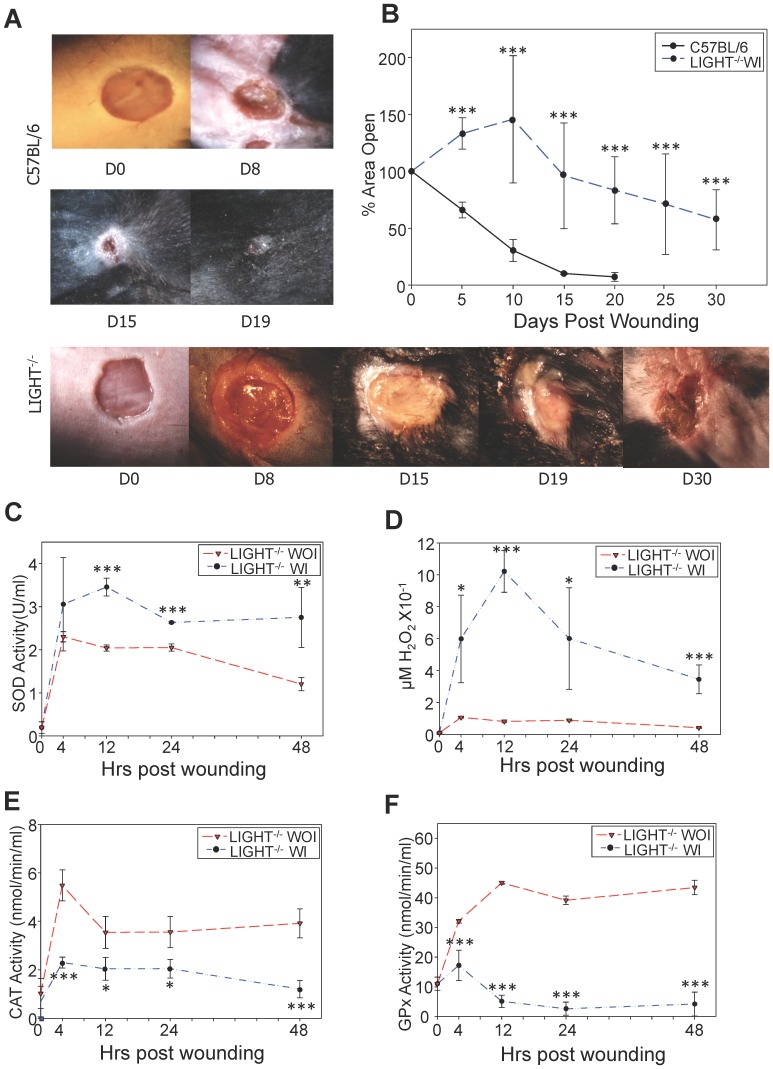
Manipulating redox parameters leads to development of chronic wounds.(A) C57BL/6 and LIGHT−/− mice were wounded and immediately treated with inhibitors for GPx and catalase followed by the application of biofilm-forming bacteria 24 hrs later. The wounds were covered with sterile tegaderm to maintain a moist wound environment and prevent external infection. The LIGHT−/− wounds became chronic and remained open for more than 30 days. n = 30. (B) Wound areas were traced using ImageJ and % open wound area was calculated. The LIGHT−/− wounds remained open for significantly longer time than the C57BL/6 wounds with similar treatment. n = 8. (C-F) SOD activity (C); H2O2 levels (D); Catalase activity (E); and GPx Activity (F) were measured as described in Figure 1. All were greatly different from controls. For all tests n = 6 at minimum. Time zero in C-F represents unwounded skin. All data are Mean ± SD. *p<0.05,**p<0.01,***p<0.001.